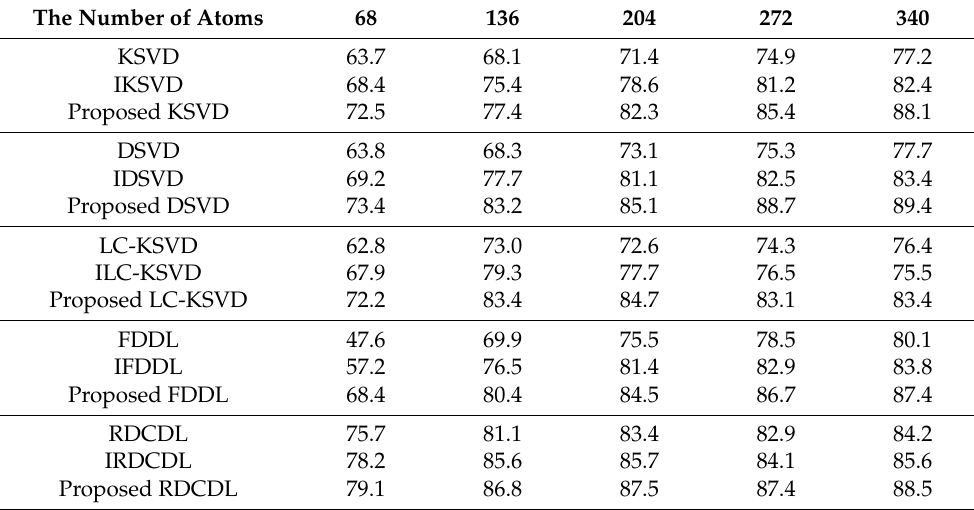
Table 2. Average accuracy (%) on the PIE face